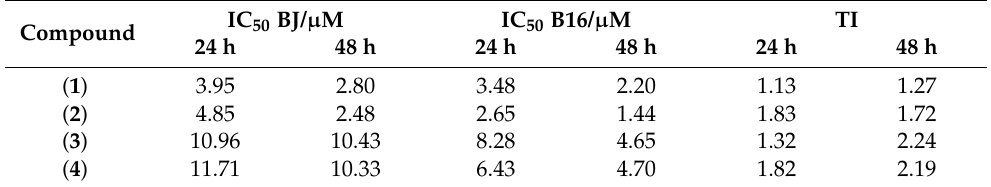
Table 3. The half-maximal inhibitory concentration (IC 50 ) and therapeutic index (TI) of the studied complexes.